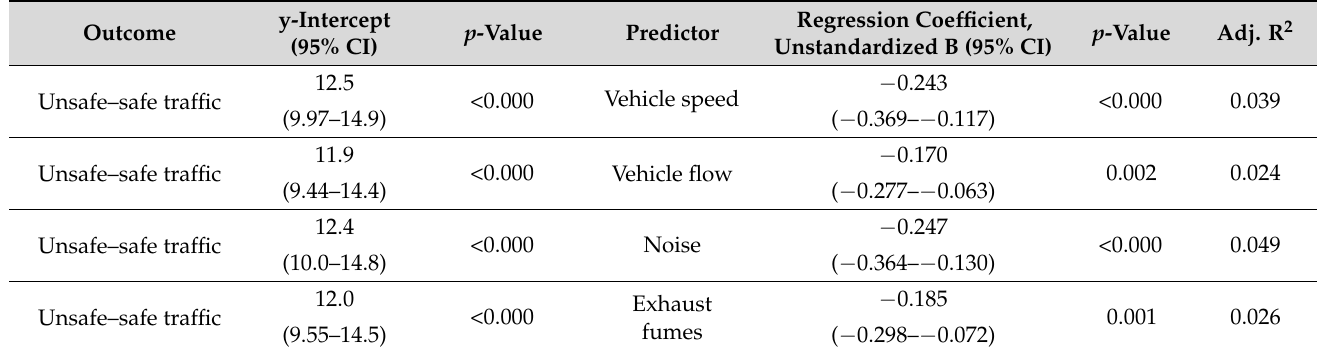
Table A6. Relations between the predictor variables and unsafe–safe traffic as an outcome.